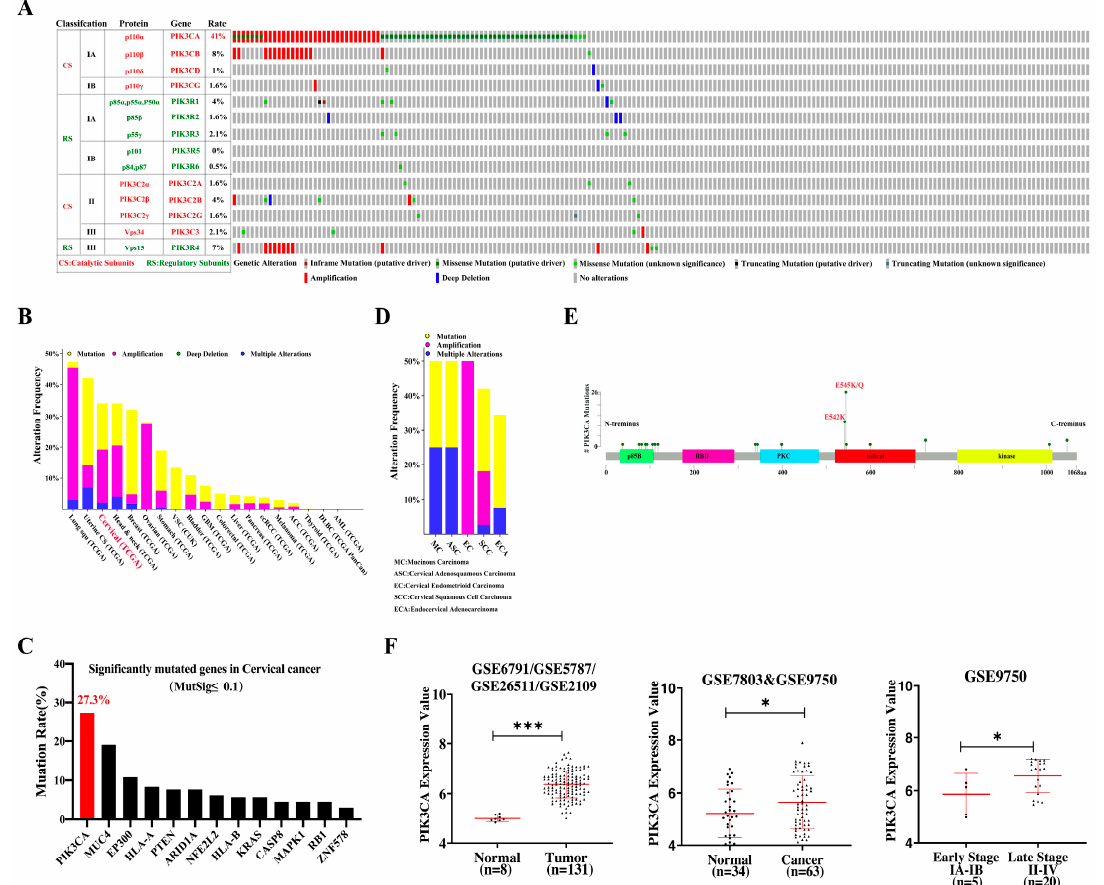
Figure 1. High frequency alteration events of the PIK3CA gene in cervical cancer based on TCGA and GEO databases. ( A ) Overview of phosphatidylinositol 3-kinase (PI3K) isoforms. In cervical cancer PIK3CA , the gene encoding p110 α alterations, occupied the highest level among the whole family of genes. The PI3K family consists of eight isoforms that are mainly grouped into three classes (I, II, III) based on protein homology and enzyme affinity for specific phosphoinositide substrates. The class I isoforms are further subdivided into class IA and class IB isoforms, referring to their mechanism of activation, with each isoform composed retrieved d of a regulatory and catalytic subunit. ( B ) Cross-cancer alteration summary for phosphoinositide-3-kinase, catalytic, alpha ( PIK3CA ) polypeptide according to The Cancer Genome Atlas (TCGA) database (retrieved from the cBioPortal for Cancer Genomics). Mutations are represented in yellow, deletions in green, amplification in rose red, and multiple alterations in violet blue. Abbreviations: Lung squ: lung squamous cell carcinoma; DLBC: lymphoid neoplasm diffuse large B-cell lymphoma; AML: acute myeloid leukemia; GBM: glioblastoma multiforme; uterine CS: uterine carcinosarcoma; CcRCC: kidney renal clear cell carcinoma; ACC: adrenocortical carcinoma; VSC(CUK): squamous cell carcinoma of the vulva (CUK, Exp Mol Med 2018).( C ) PIK3CA is one of the most frequently mutated genes in cervical cancer (cBioPortal). ( D ) PIK3CA alterations in different types of cervical cancer based on the TCGA database (retrieved from cBioPortal). ( E ) Representative graphical summary of PIK3CA mutations mapped across the gene in 191 cervical cancer TCGA samples (from cBioPortal, which provides visualization, analysis and downloads of large-scale cancer genomic datasets, http: // www.cbioportal.org / ). Green circles represent missense mutations. A “hotspot” mutation, mapped to two sites, E545 and E542, in the helical domain (exon 9) of p110 α . ( F ) Increased mRNA expression of PIK3CA in cervical cancer shows a significant positive relationship with the stage of advanced cervical cancer, compared to early stage cancer, based on two platforms consisting of multiple Gene Expression Omnibus (GEO) series datasets. * p < 0.05, *** p <